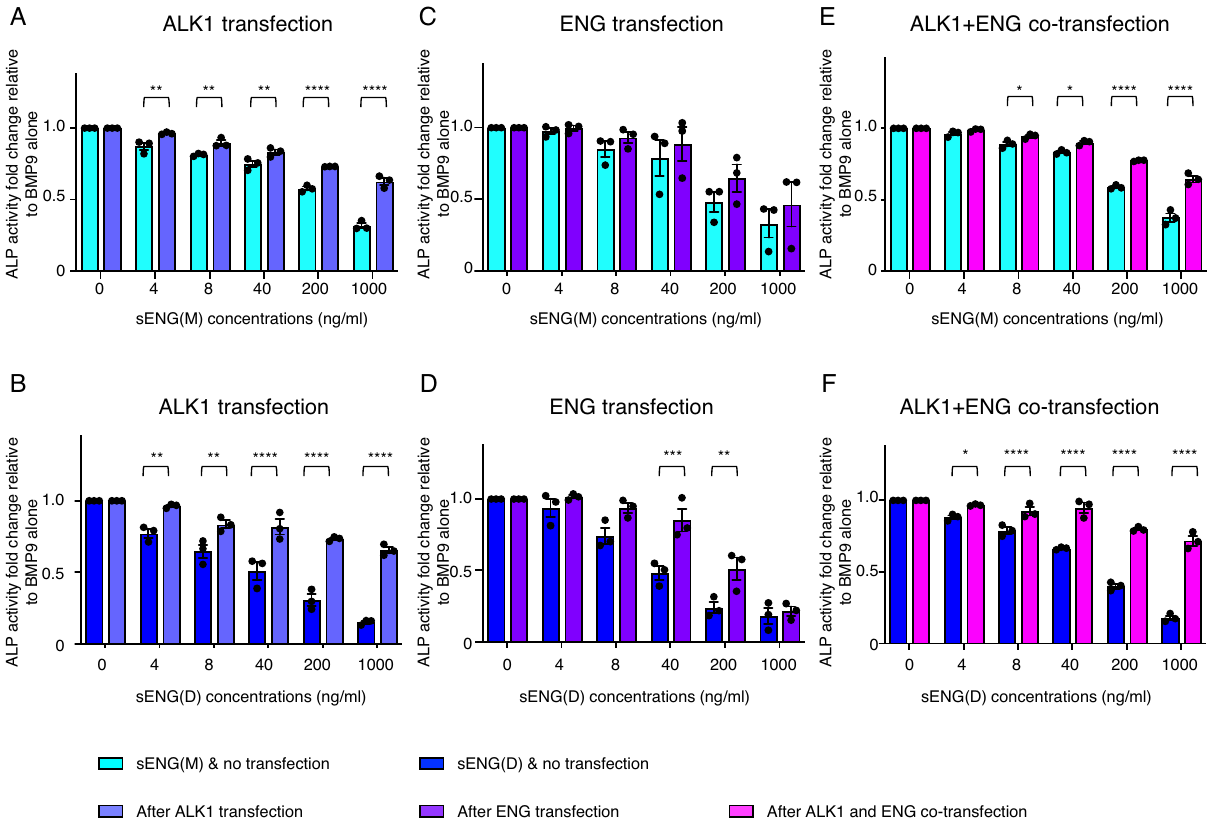
Figure 6. Transfecting full-length ALK1 and ENG reduces the inhibitory effect of sENG on the BMP9-induced ALP activity in C2C12 cells. C2C12 cells were transfected with pcDNA3.1-ALK1 (blue-purple bars), pDisplay- ENG (purple bars), or both (magenta bars), and treated with BMP9 (10 ng/ml) in the presence of different concentrations of sENG(M) or sENG(D). ALP assays were performed as described in the methods. Three independent transfection and treatment experiments were performed. Data were normalized to the BMP9 only treatment in each experiment and Mean ± SEM are shown. Two-way ANOVA comparing sENG effect on BMP9 signaling in receptor-transfected and vector control-transfected cells. * P < 0.05, ** P < 0.01, *** P < 0.001, **** P < 0.0001.